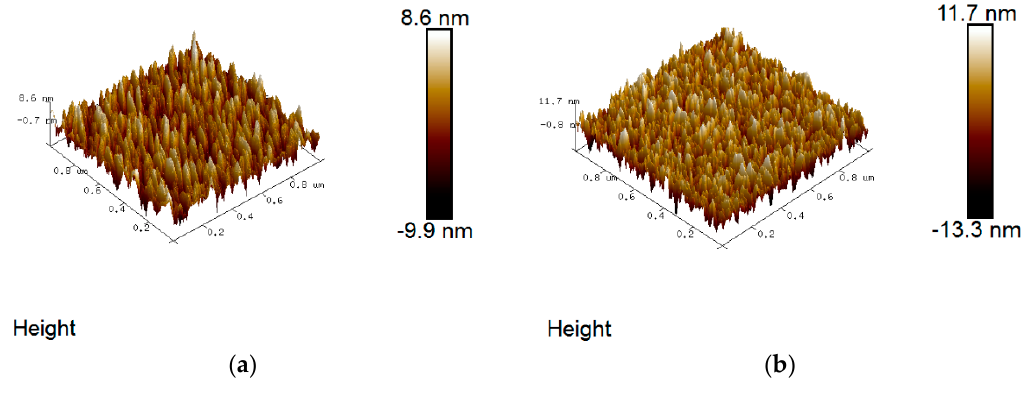
Figure 3. Cont. Figure 3.